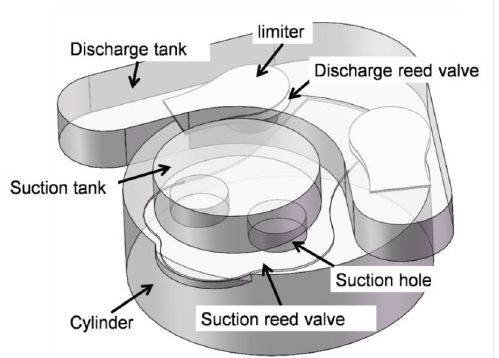
Figure 2. The schematic diagram of the compressor with a reed valve.